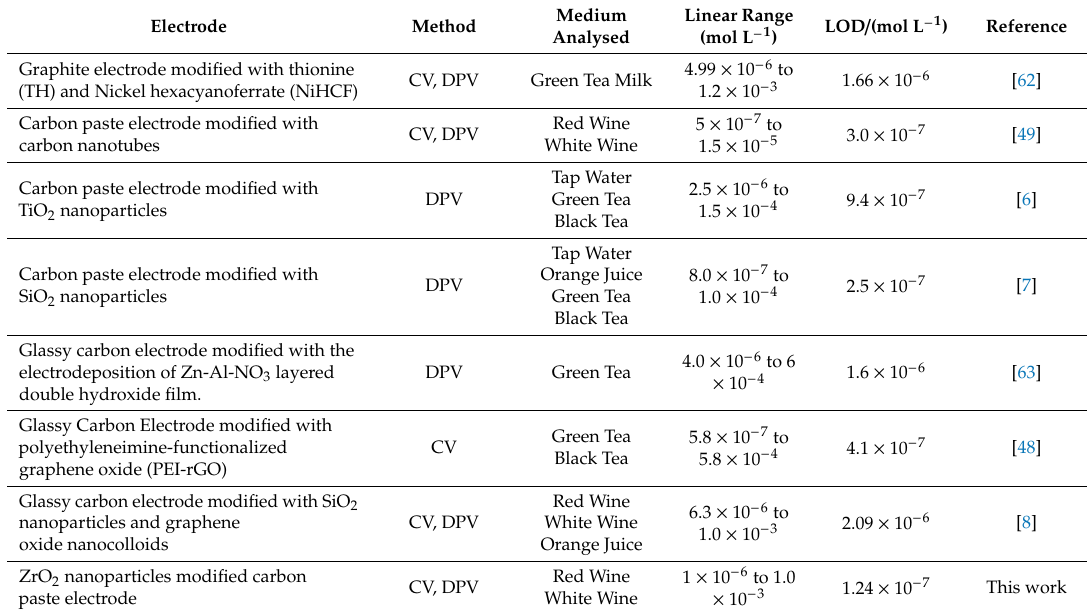
Table 1. Electrochemical methods used in the determination of gallic acid and their e ffi ciency.